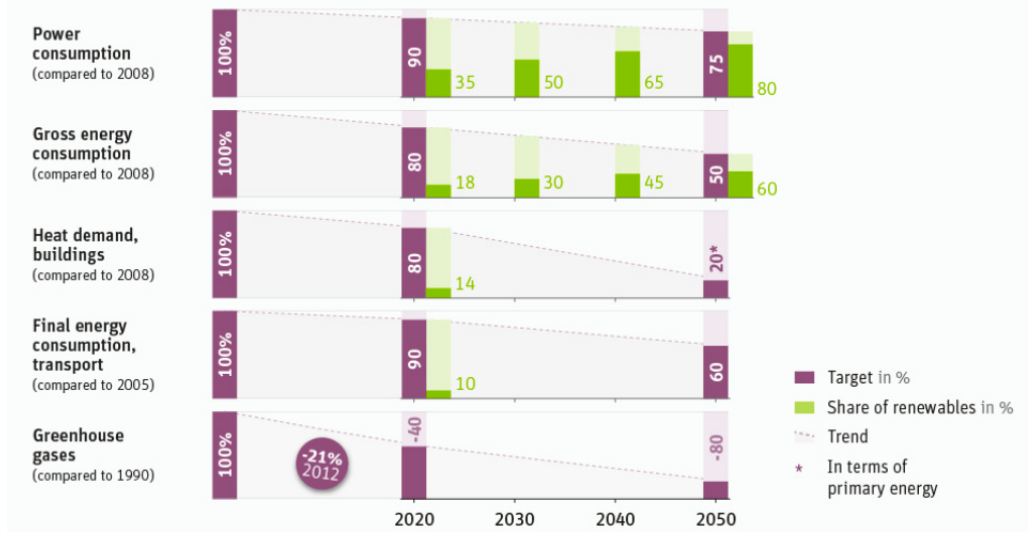
Figure 3. Long-term, comprehensive energy and climate targets set by the German government in 2010